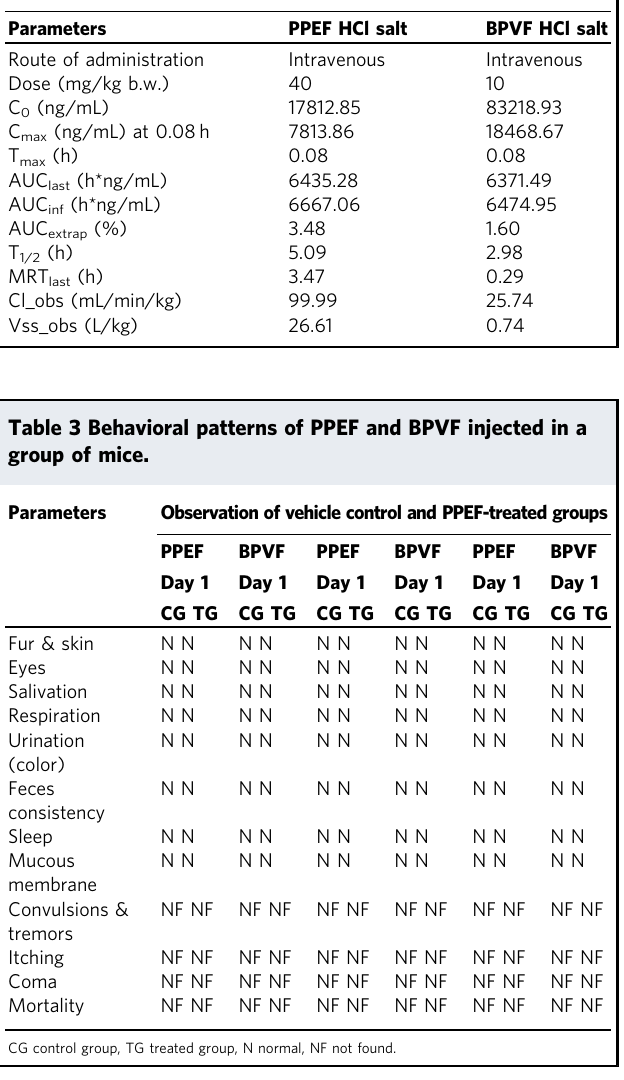
loading buffer. The level of DNA products was analyzed by electrophoresis in a 15% sequencing gel followed by Phosphor-Imager analysis of the dried gel 55 .